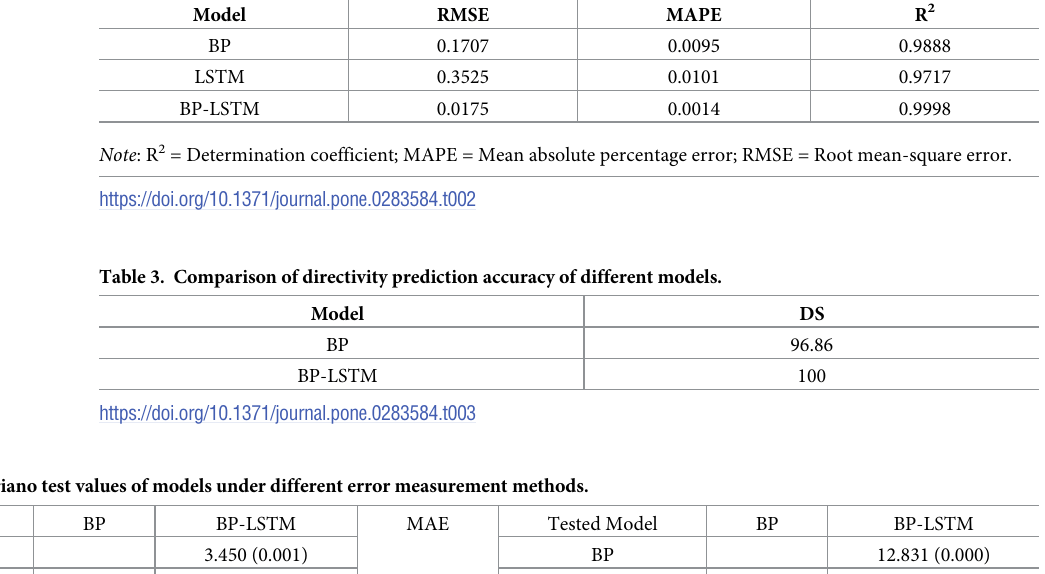
Note : MAD = Median absolute deviation; MAE = Mean absolute